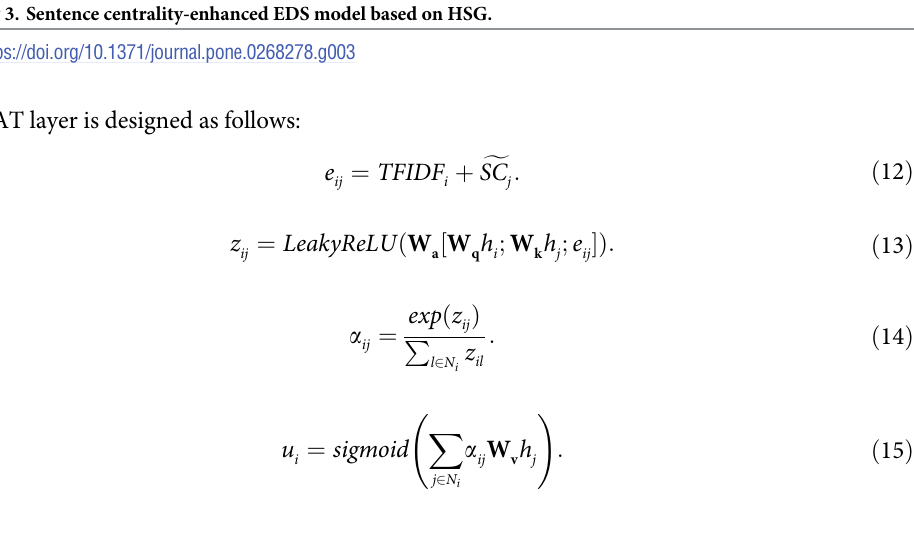
Fig 3. Sentence centrality-enhanced EDS model based on